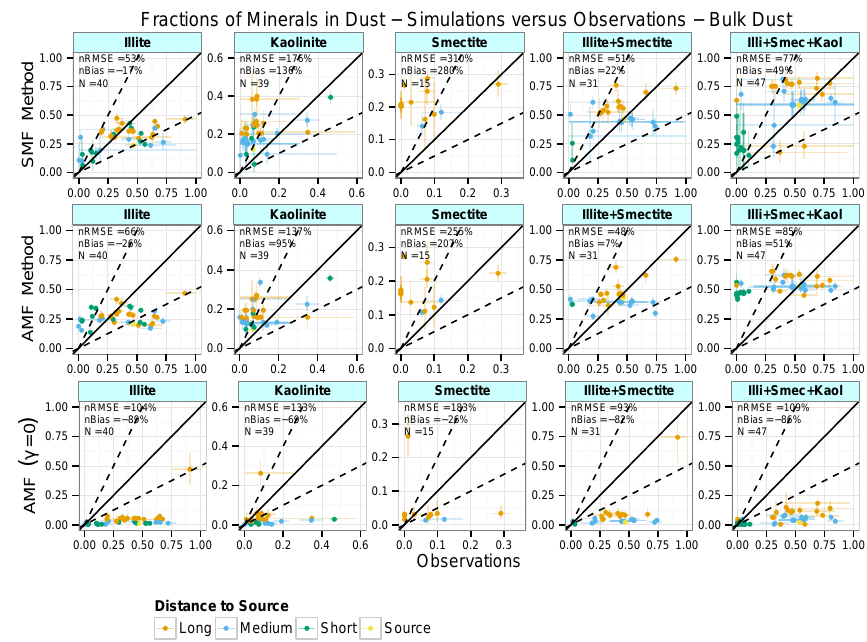
Figure 6. Same as Fig. 4 but for bulk (clay plus silt) mineral fractions of illite, kaolinite, smectite, the sum of illite and smectite, and all